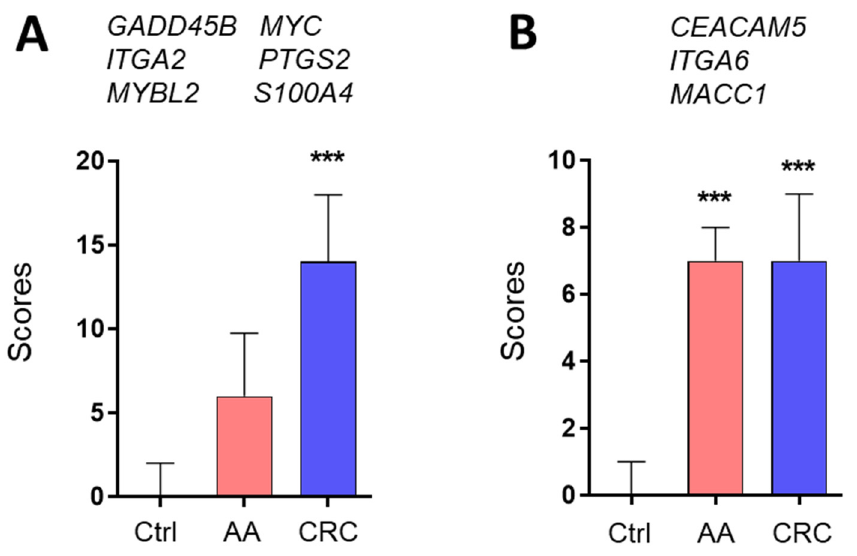
Figure 2. ROC curves were determined for the nine targets characterized in Figure 1 and areas under the curve were calculated to identify those equal or above 0.8 (dotted lines) for AA and CRC.